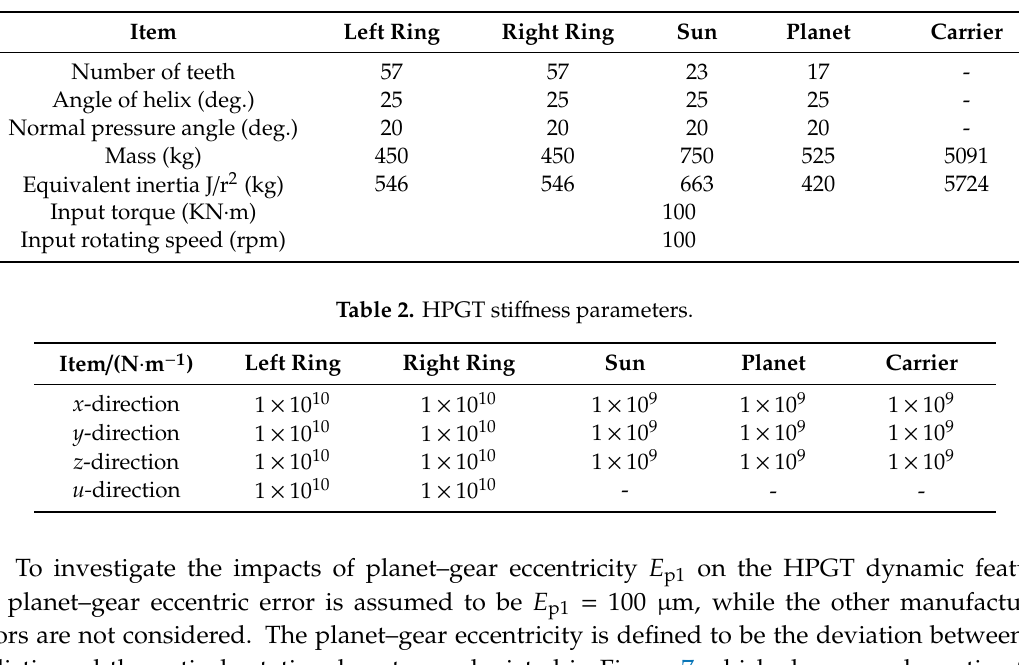
Table 1. Parameters of the HPGT system.